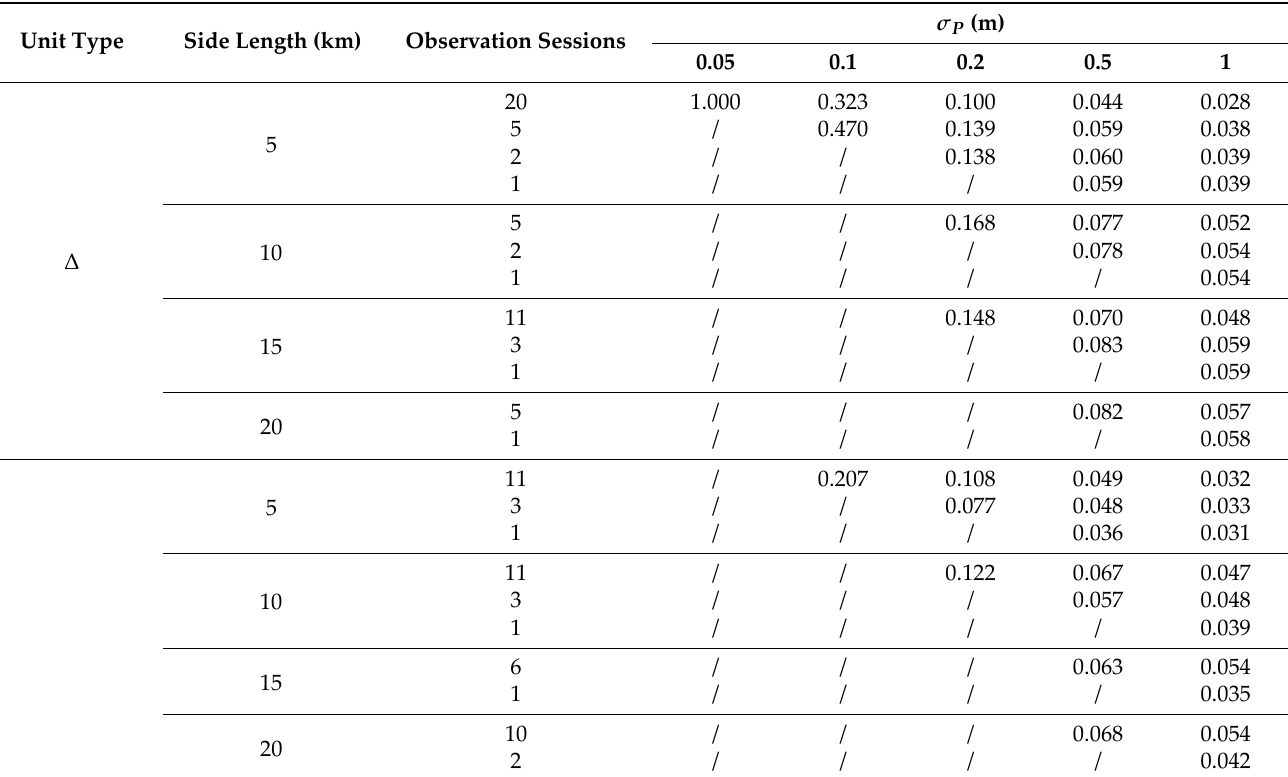
Table 8. The comprehensive scores of design schemes for the seafloor PNT network at different precision